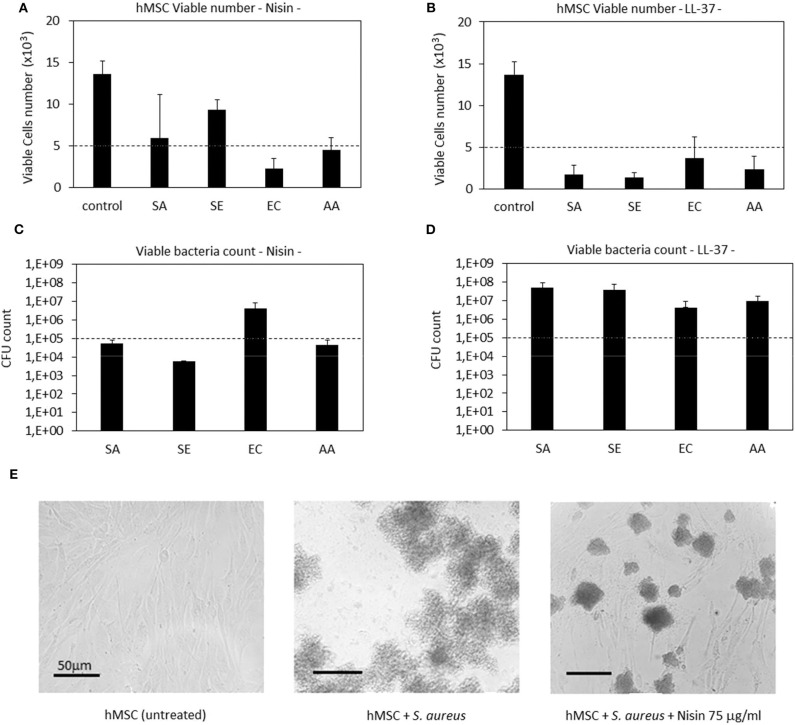
Cells-bacteria co-culture. Nisin showed a targeted activity in decreasing the viable bacteria number (C) and at the same time preserving cells (A). Differently, the use of LL-37 was not effective in protecting cells from infection; in fact, they decreased from the starting number (B) while the bacteria were able to proliferate (D). Finally, representative optical micrographs of S. aureus and hMSC cultures are shown (E) to demonstrate the difference between the control cells (left), cells and bacteria co-culture without Nisin (middle) and cells and bacteria co-culture with the addition of Nisin (right). Bars represent means and standard deviations; dashed lines indicate starting cell and bacteria numbers. SA, S. aureus; SE, S. epidermidis; EC, E. coli; AA, A. actinomycetemcomitans.